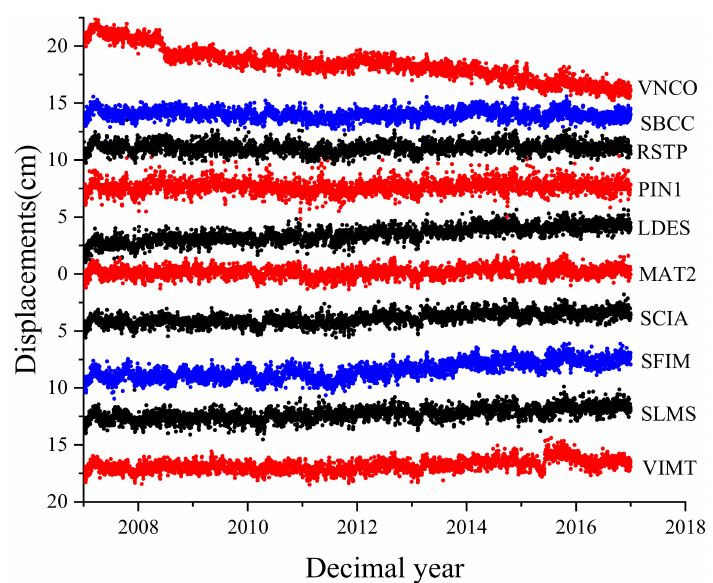
Figure 2. The vertical displacements of 20 selected GNSS sites on the North American